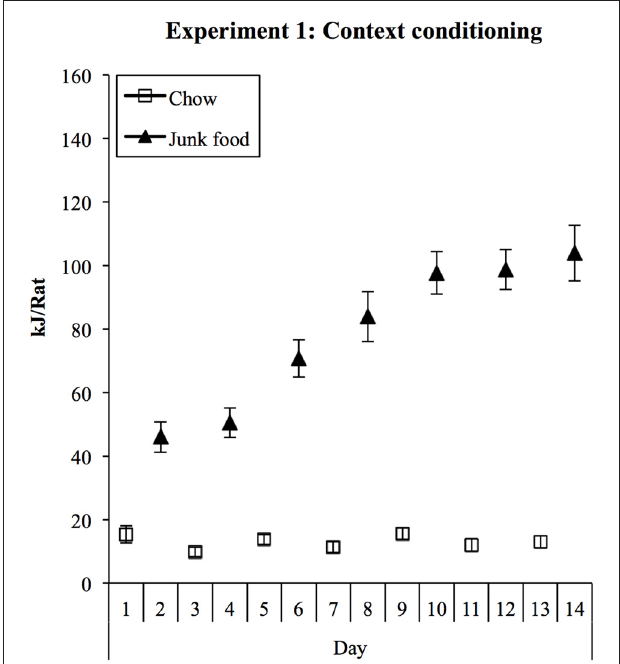
FIGURE 1 | Experiment 1 context conditioning. In 1-h daily sessions, rats were exposed to a context containing three “junk” foods (JFs) or to another context containing chow (Chow). Consumption in the JF context was substantially greater from the first session onwards and increased steadily during training, while consumption in the chow context remained low.